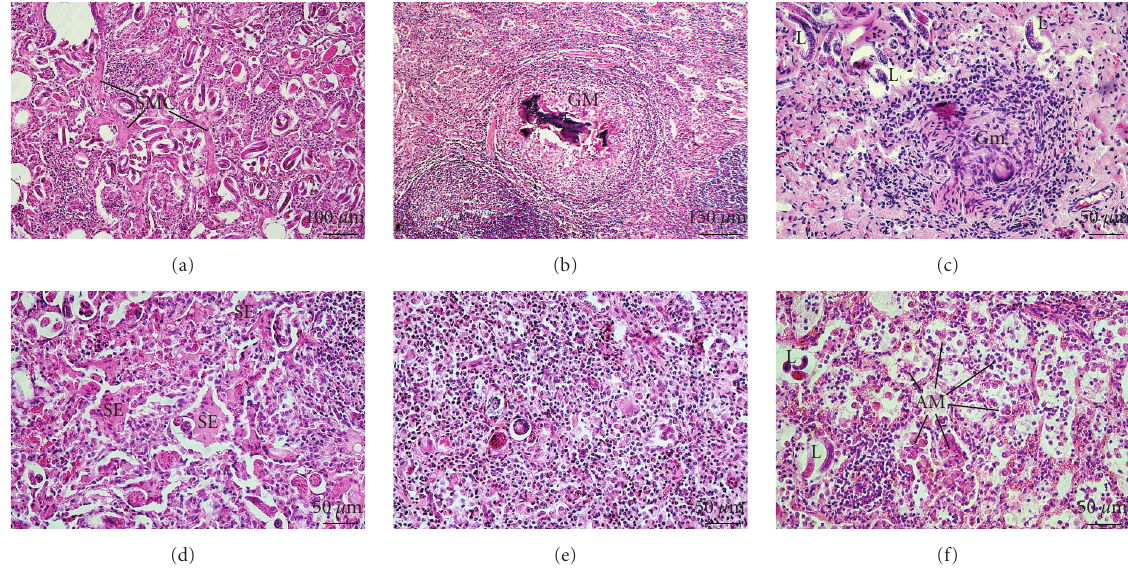
Figure 3: (a) Sheep, lung, a nodule with M. capillaris, alveoli with parasite forms, smooth muscle cell (SMC) hyperplasia and a thickening of the alveolar septa. (b) Sheep, lung, a nodule with M. capillaris , parasite granuloma (Gm) with calcification in the necrotic centre and lymphoid hyperplasia in the periphery. (c) Mouflon, lung, a nodule with M. capillaris . Granuloma with giant cells (Gm). First stage larva (L). (d) Sheep, lung, a lobular lesion with P. hobmaieri . Serous alveolitis (SE). (e) Sheep, lung, a lobular lesion with P. hobmaieri . Alveoli with epitheloid and giant cells. (f) Mouflon, lung, a nodule with M. capillaris . Alveolar macrophages (AM) in the alveolar lumen (macrophage